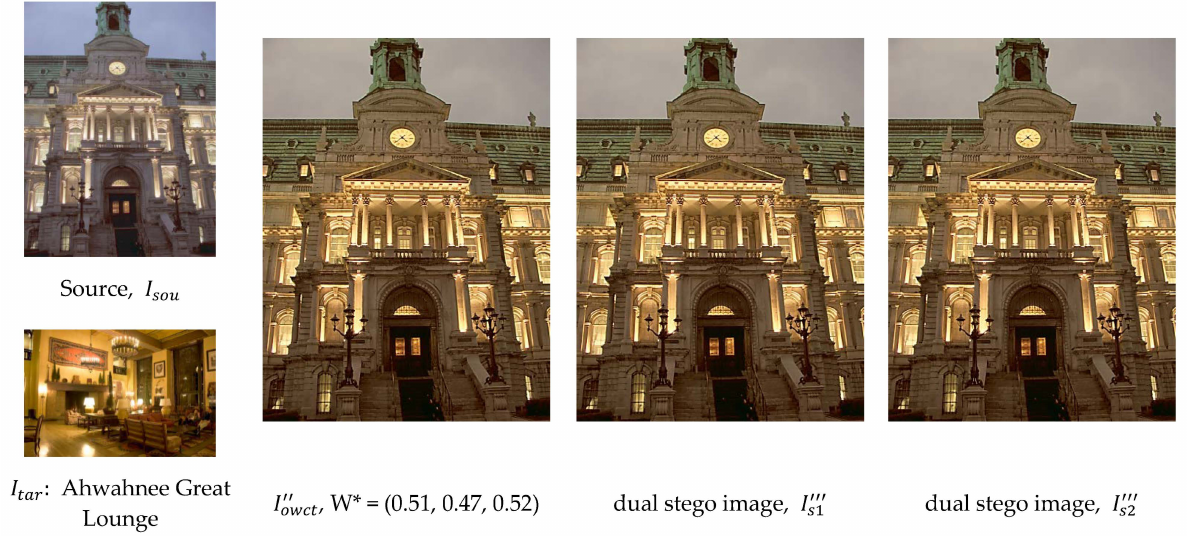
Figure 4. The visual inspection of the stego images, “Clock Building,” produced by our